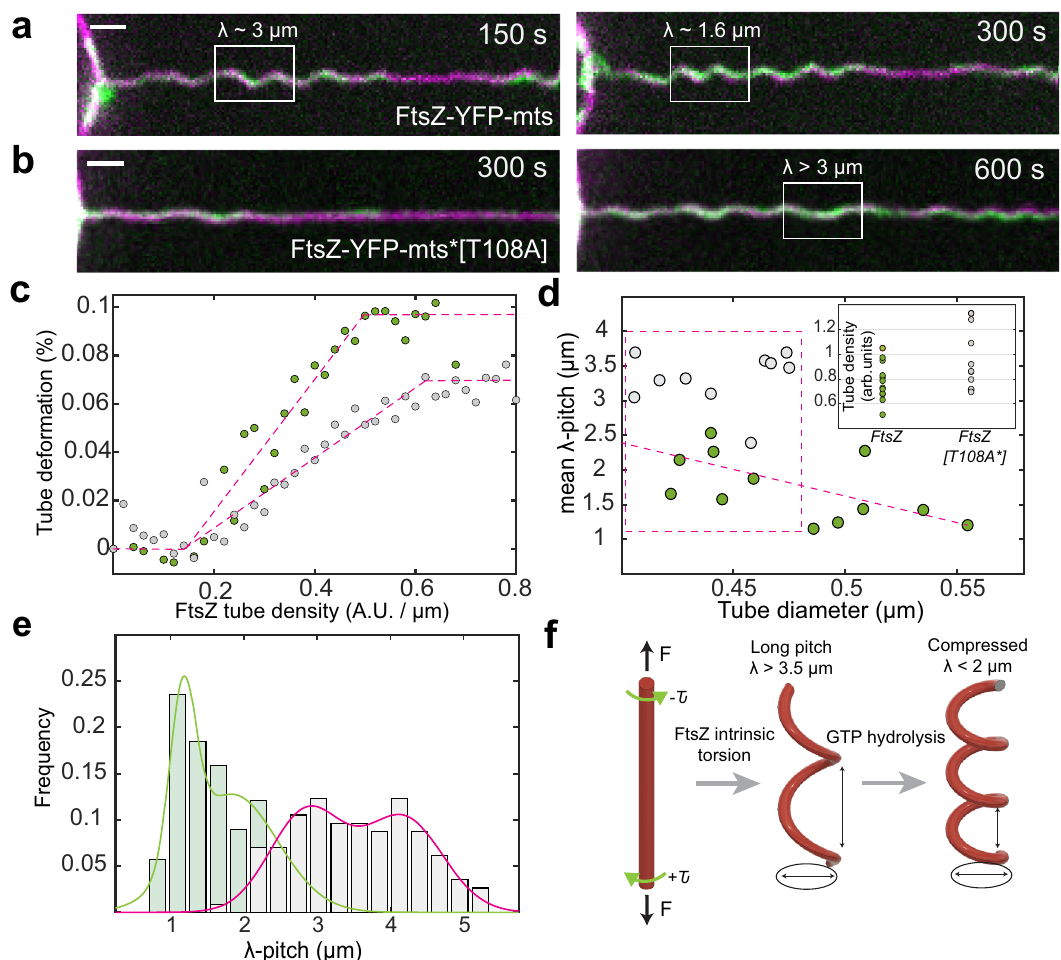
Fig. 3 GTPase activity in FtsZ fi laments promote spring compression and condensation. Time-lapse acquisition of lipid tubes covered by a FtsZ-YFP-mts ( N = 12) and b FtsZ-YFP-mts*[T108A] ( N = 10). Both proteins promote helical deformations with the difference that GTPase activity induces compression ( λ ~1.6 µ m) of initially longer pitch ( λ > 3 µ m). FtsZ-YFP-mts is shown in green while lipids are shown in magenta (scale bar = 2 µ m). c Tube deformation (arclength) in ( a, b ) against FtsZ-YFP-mts (green circles) and FtsZ-YFP-mts*[T108A] (gray circles) tube density, as function of time (Fig. 2SD), evidenced that GTPase activity caused greater tube deformation. d To rule out that compression was biased by the de fl ation state, we plotted tube diameter vs. mean pitch for FtsZ-YFP-mts ( N = 12) (green) and FtsZ-YFP-mts*[T108A] ( N = 10) (gray) in steady state. Despite of higher tube densities (arbitrary units) for FtsZ-YFP-mts*[T108A] as shown in ( d — insert), the mean pitch for no GTPase case is longer at comparable tube diameters. e We observed two clear pitch states for FtsZ-YFP-mts (light green bars/green line) and FtsZ-YFP-mts*[T108A] (gray bars/magenta line) with a clear dominance of longer pitch for the mutant without GTPase activity. f Helical deformations can be understood by twisting an elastic rod subjected to constant force. We postulate that FtsZ has an intrinsic torsion that is enhanced by GTPase activity, driving further compression. Intrinsic FtsZ torsion rules long-pitch transformations ( λ > 3 µ m) while GTP enhances further torsion causing higher pitch states ( λ < 2 µ